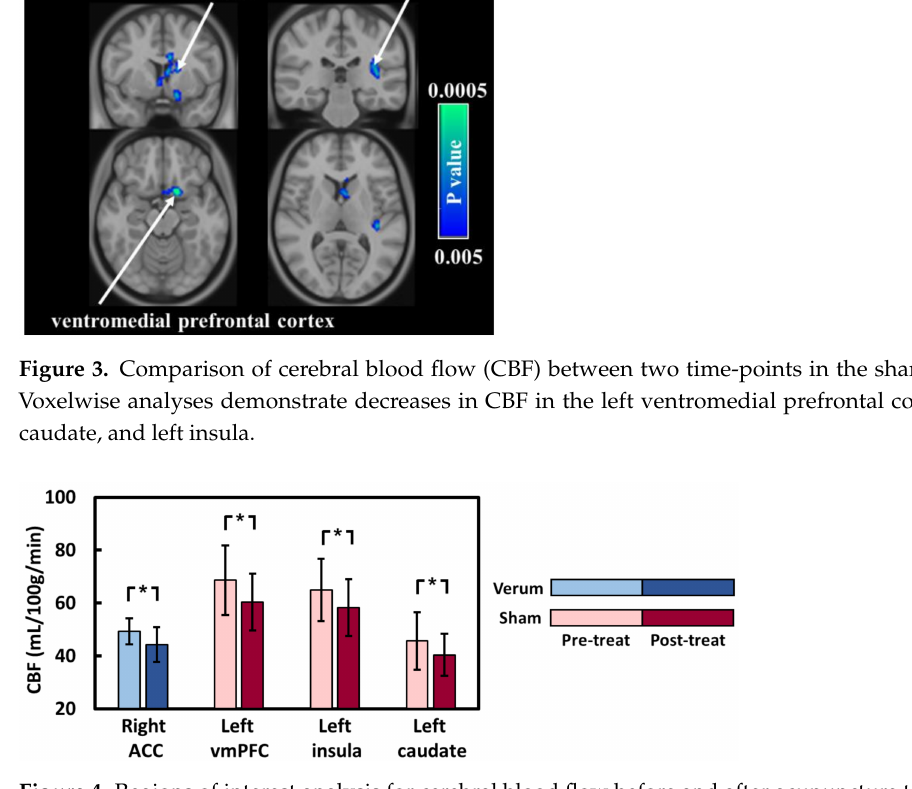
Figure 4. Regions of interest analysis for cerebral blood flow before and after acupuncture treatment. *: p < 0.01.